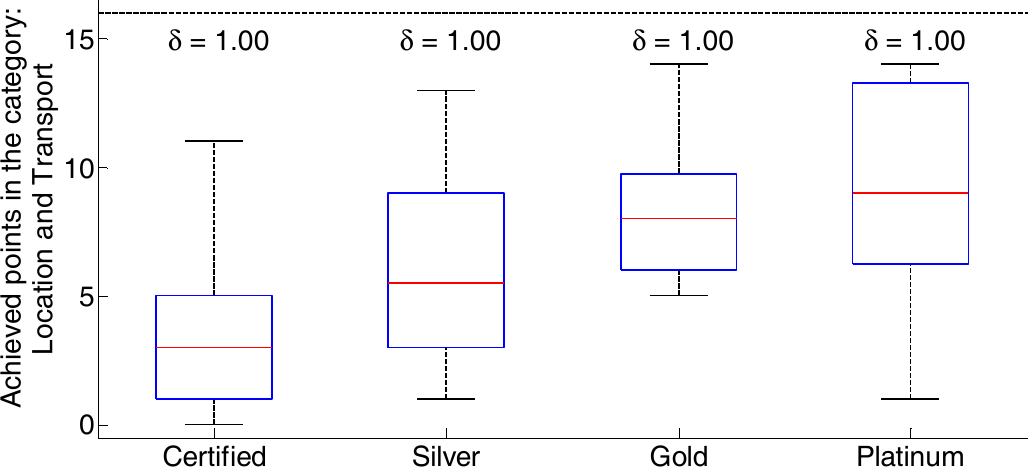
Figure 2. The boxplot results and Cliff’s δ effect size between possible and achieved points in the Location and Transportation (LT) category. Effect size is considered to be: very high if | δ | < 0.147 (bold font), high if 0.147 < | δ | < 0.33 (bold italic font), medium if 0.33 < | δ | < 0.474 (italic font), and low if | δ | ≥ 0.474 (normal font).